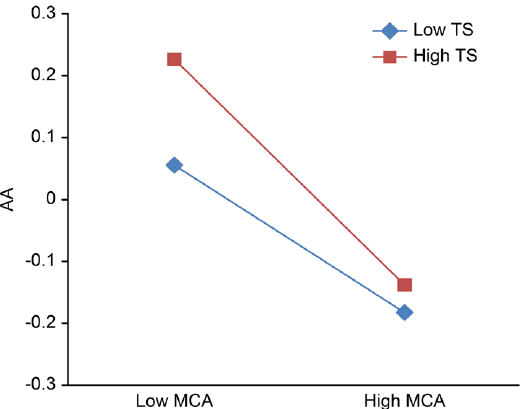
Figure 2. Teacher support adjustment chart a. MCA, mother-adolescent attachment; TS, teacher support; AA, adolescent anxiety.